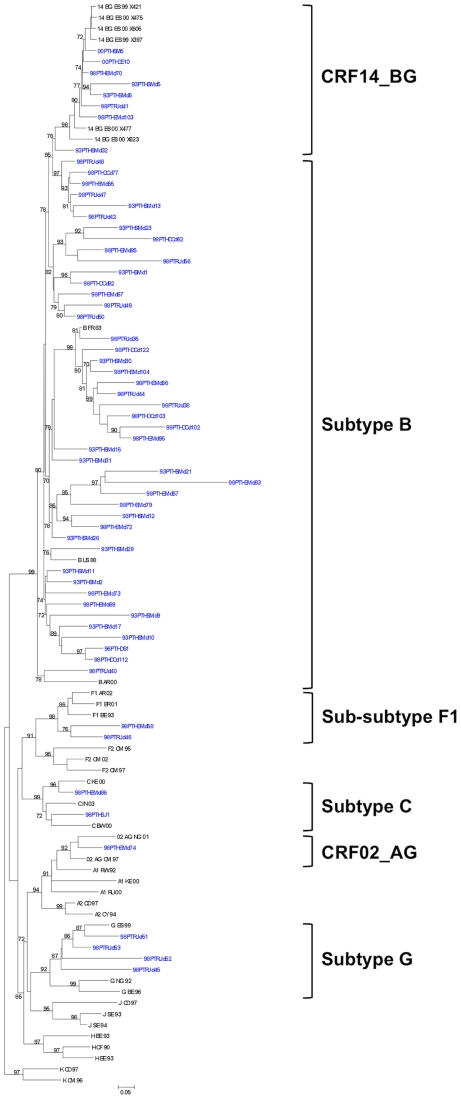
Phylogenetic analysis of Env gene sequences from HIV-1 infected patients.The maximum likelihood phylogenetic trees were constructed with reference sequences from all HIV-1 subtypes. The bootstrap values supporting the internal branches defining a subtype or a CRF are shown. Bootstrap values of 70% or greater provide reasonable confidence for assignment of an individual segment to one or the other genotype. The scale represents number of base substitutions per site.